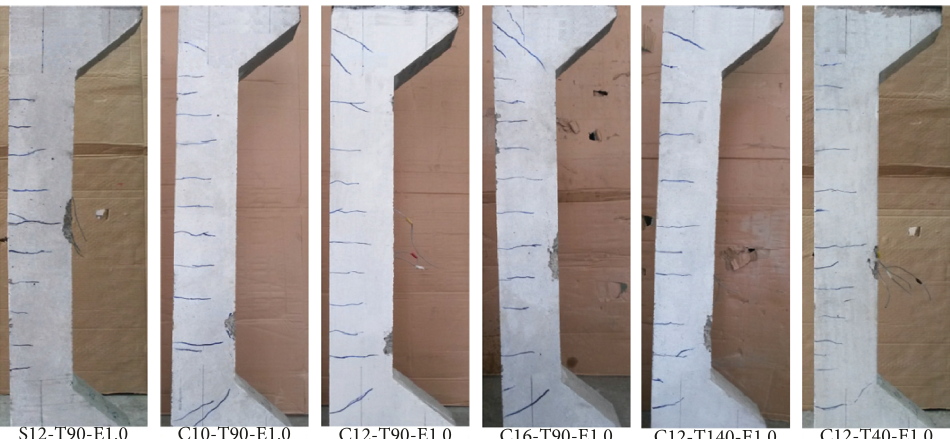
Figure 6: Crack pattern and mode of failure of column specimens with e � 1.0 h .